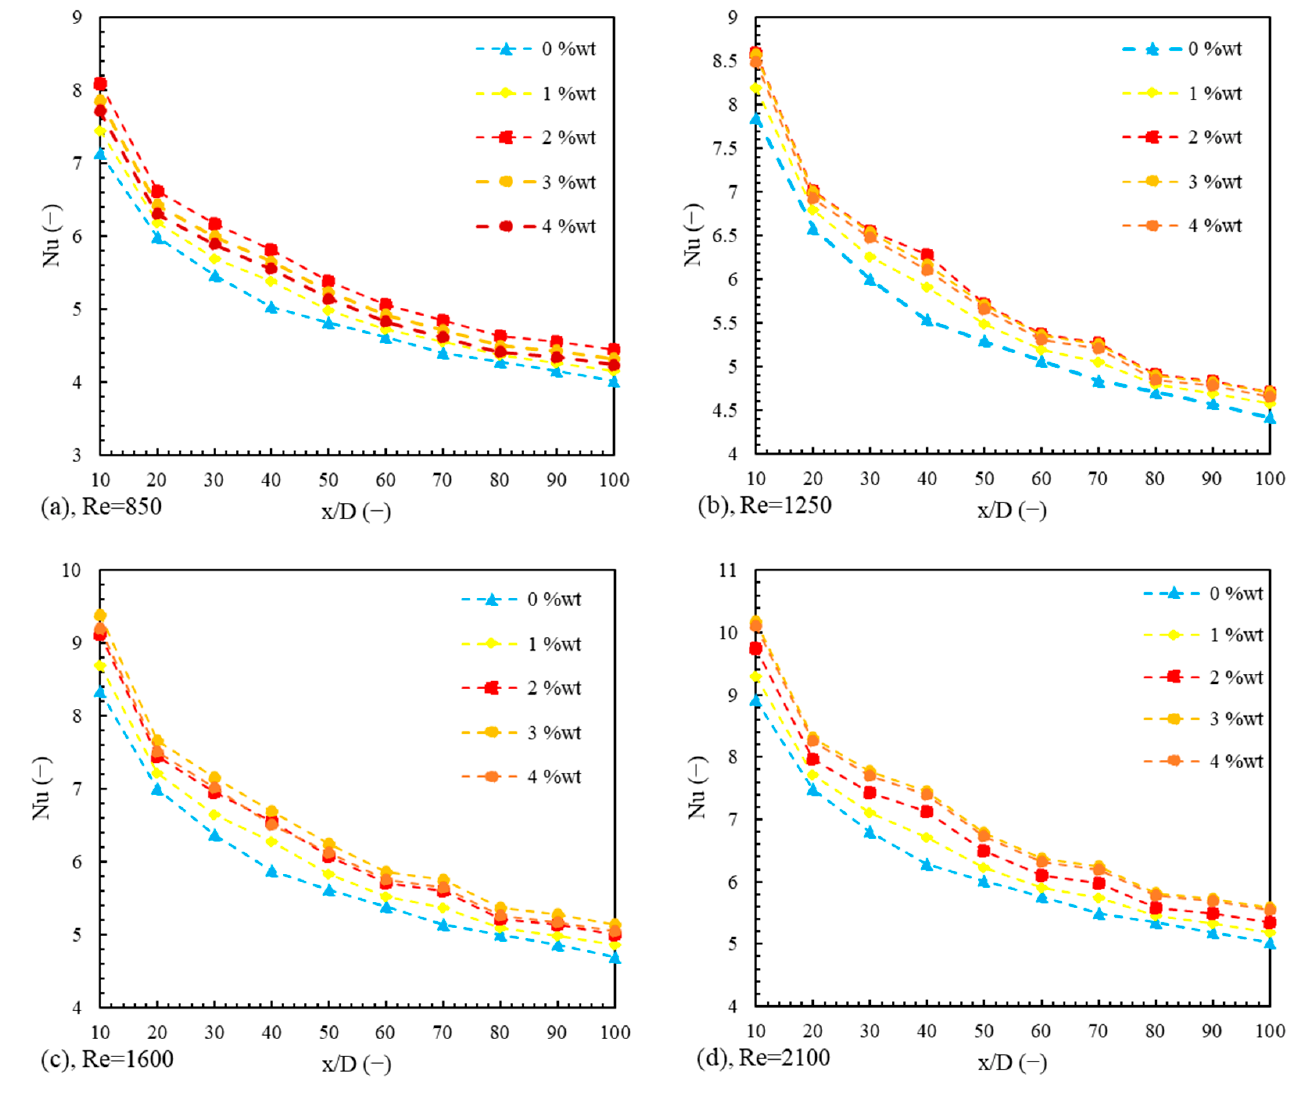
Figure 9. The results of local Nu for square cross-section with different nanoparticle concentrations in ( a ) Re = 850, ( b ) Re = 1250, ( c ) Re = 1600, and ( d ) Re = 2100.